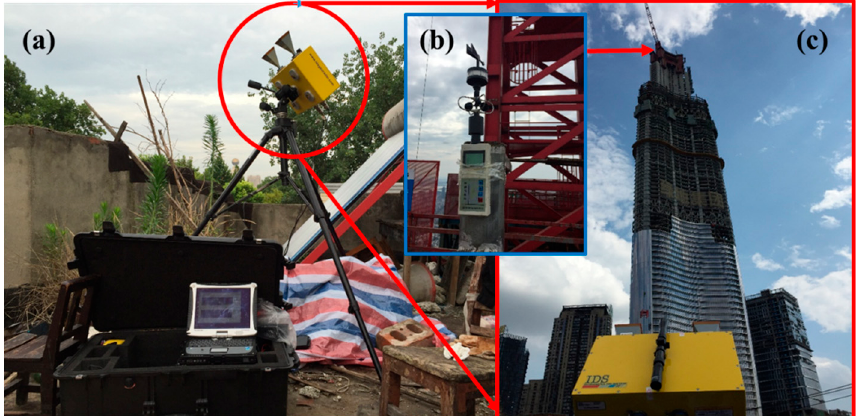
Figure 4. Location of the IBIS-S-1 system in the north–south direction. ( a ) View of the IBIS-S-1 interferometric radar on S1 (located in a farmhouse roof). ( b ) Weather station installed on the roof of the monitored building. ( c ) Ground view of the WGC from the location of the IBIS-S-1 interferometric radar. Table 1. Configuration of IBIS-S systems for the measurement campaign.